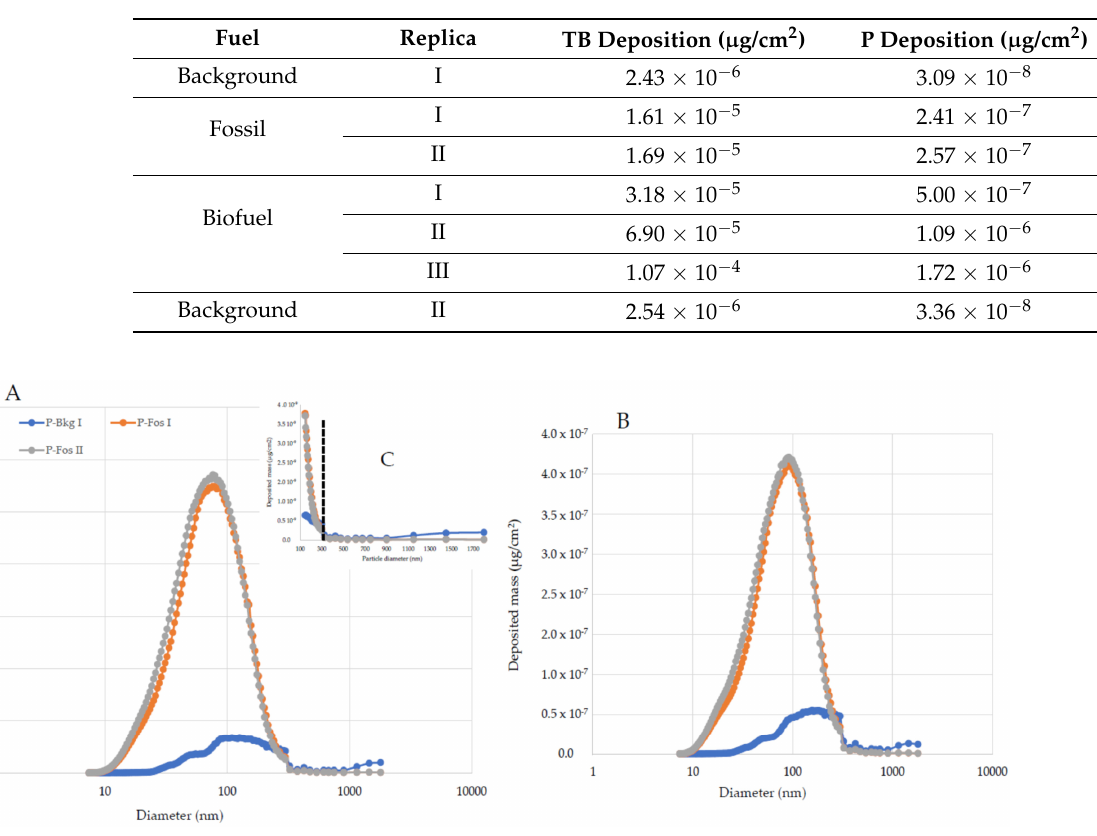
Figure 3. Pulmonary deposition of fossil fuel emissions (P-Fos I and P-Fos II) emitted, and the background (P-Bkg I) particles for the pulmonary ( A ) and trachea–bronchial ( B ) regions. Maximal contribution of emission is within 300 nm ( C ), after which background particulate distribution accounts for the measured deposition. One maximal peak of deposition (80 nm) is evident.